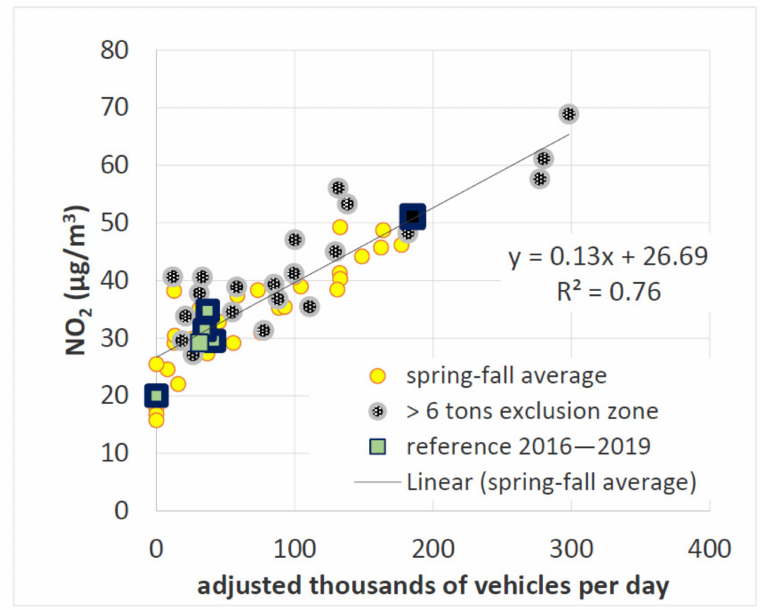
Figure 7. Relationship between adjusted traffic intensity (traffic count × (1 + fraction of vehicles travelling uphill + 3 × fraction of vehicles stopping at an intersection)) and NO 2 concentrations measured by passive samplers (average of all measurement periods) and by the national monitoring network (average of